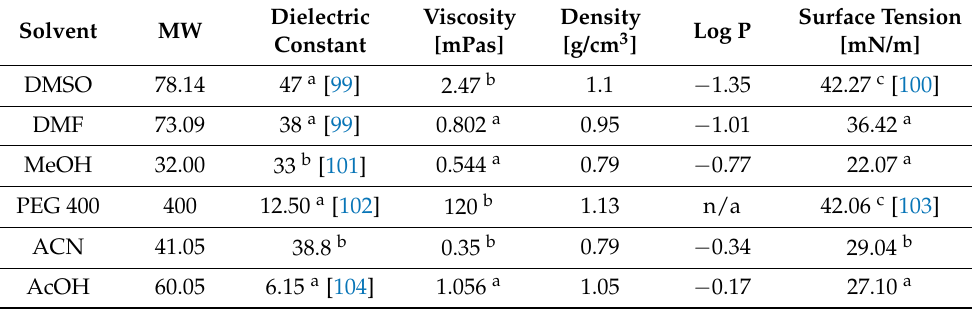
Table A1. Selected properties of the screened solvents (based on PubChem data or supplier data sheets unless otherwise